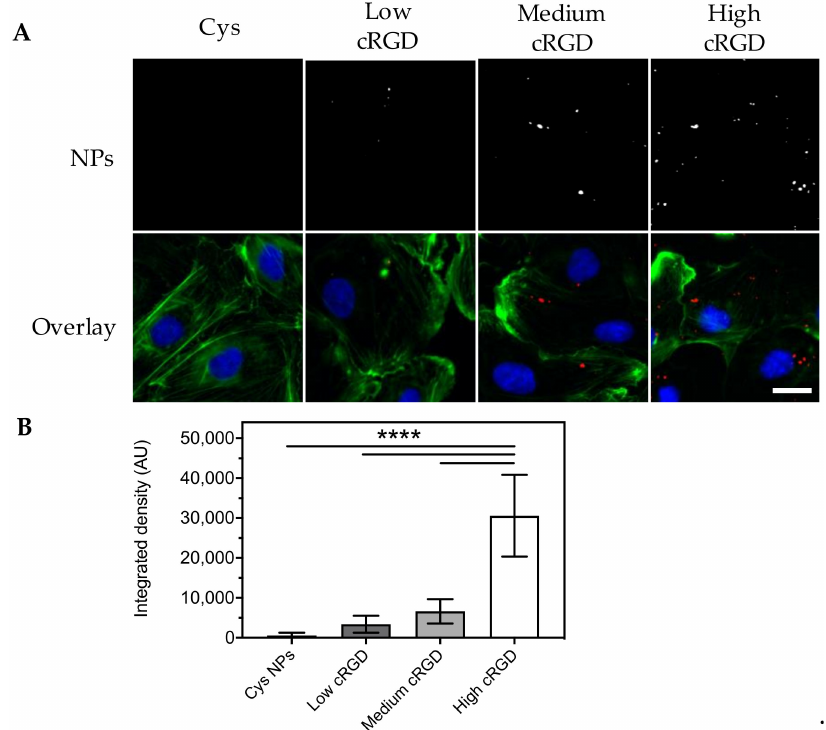
Figure 3. Association of Cys-NPs and cRGD-NPs of di ff erent ligand densities to HUVECs after 1 h incubation under flow (shear rate 300 s − 1 ) in Endothelial Basal Medium (EBM-2) at 37 ◦ C. ( A ) Representative images obtained with an epifluorescence microscope (cropped images). Nuclei are stained in blue, cytoskeleton (F-actin) is stained in green and NPs are observed in red. The same brightness and contrast settings were used for the red channel in all images. ( B ) Image analysis: fluorescent signal for the NPs is reported as integrated density (n = 10). All images obtained from the di ff erent formulations were processed in the same manner (background subtraction and equal thresholding). Data (mean ± SD) were analyzed by one-way ANOVA followed by Tukey’s multiple comparison test; **** p -value < 0.0001. Scale bar represents 20 µ